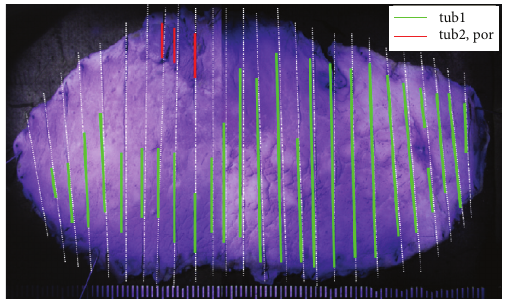
Figure 5: Final histological mapping of the endoscopically resected specimen after crystal violet